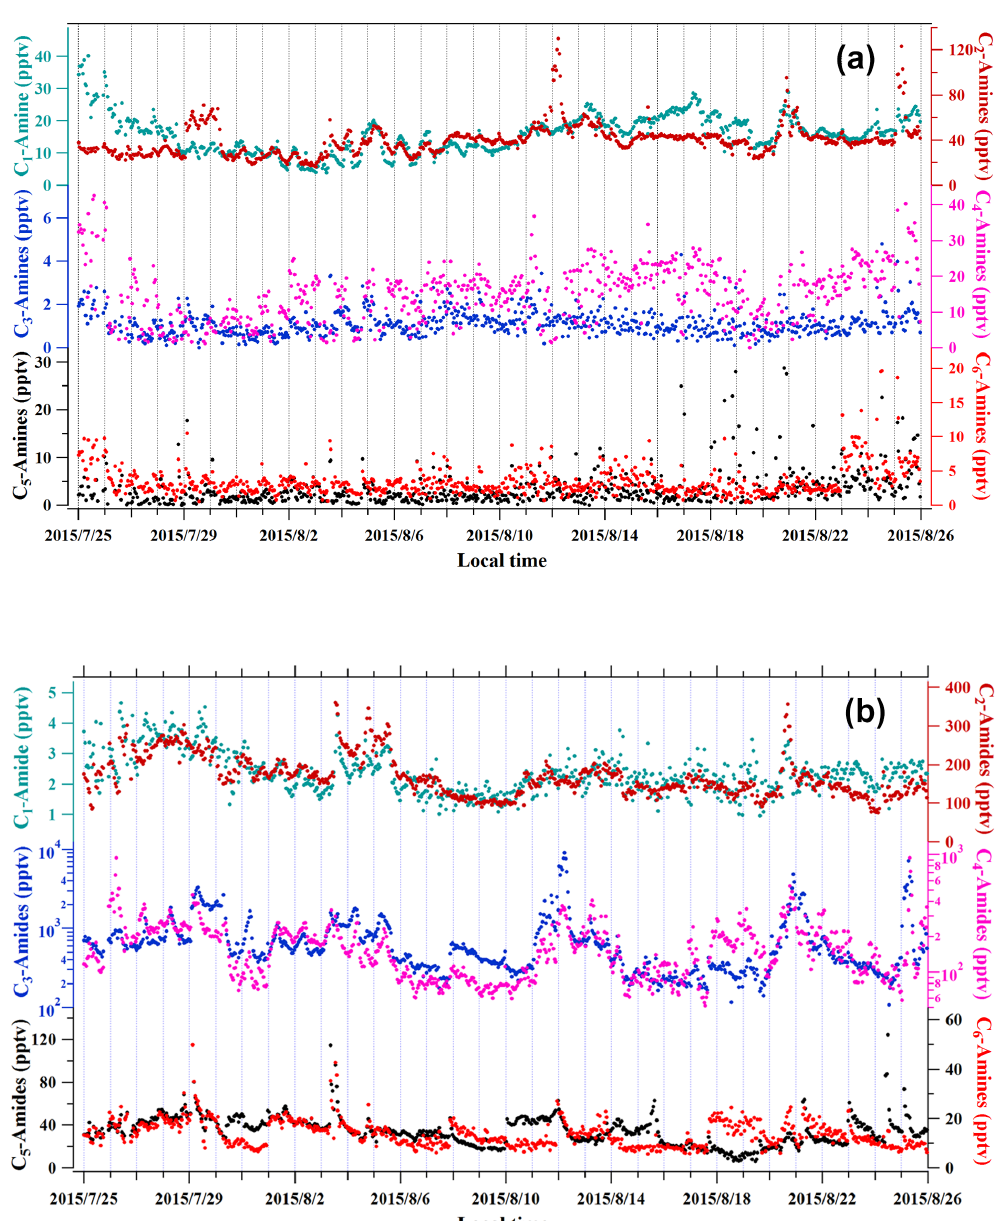
Figure 5. Time series of amines (a) and amides (b) . Concentrations of amines and amides are 15min average values.